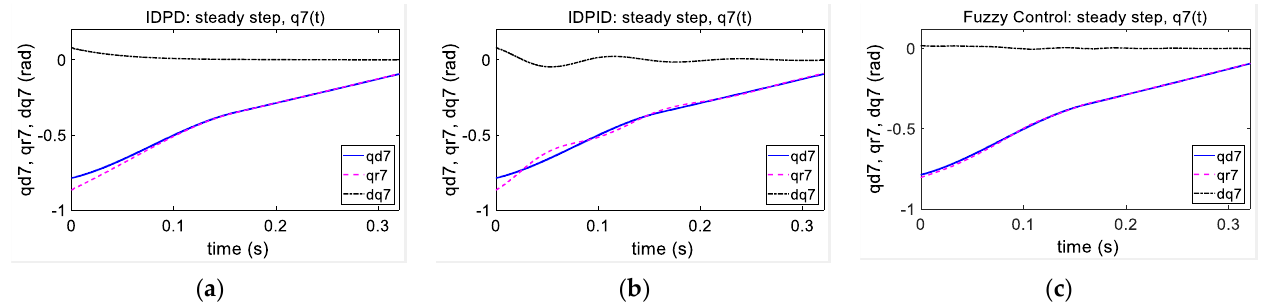
Figure 16. Simulation results of controllers for bipedal robots at the steady step: ( a ) IDPD controller; ( b ) IDPID controller; ( c ) fuzzy controller.